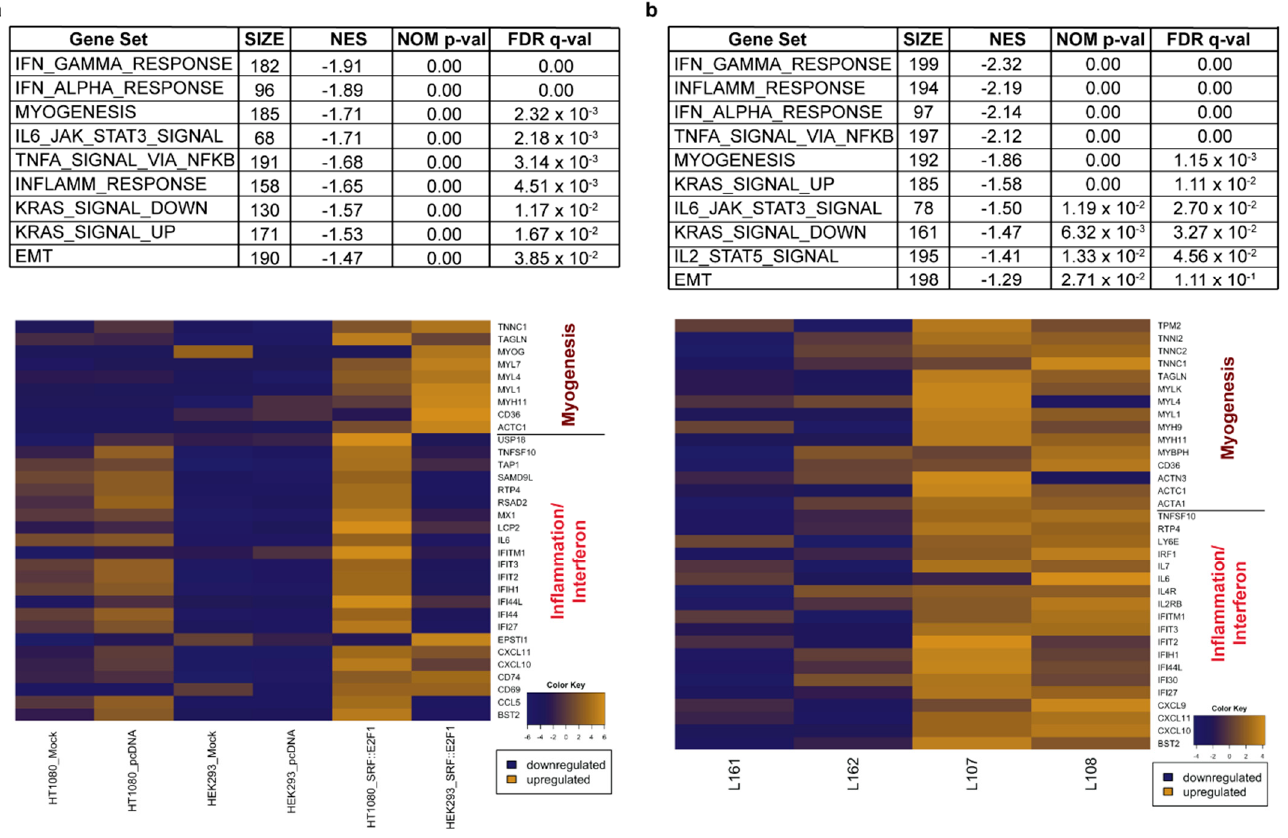
Figure 5. GSEA analyses of hallmark gene sets in SRF fusion-positive samples. Tables and heatmaps showing that myogenesis and inflammation/interferon were among the top enriched pathways ( a ) in SRF::E2F1 -transfected HEK293 and HT1080 and ( b ) in SRF -fusion-positive tumors (L107 and L108) vs EWSR1 -rearranged MN (L161 and L162). NES: Normalized Enrichment Score; NOM p-val: Nominal p -value; FDR q-val: False Discovery Rate q-value.